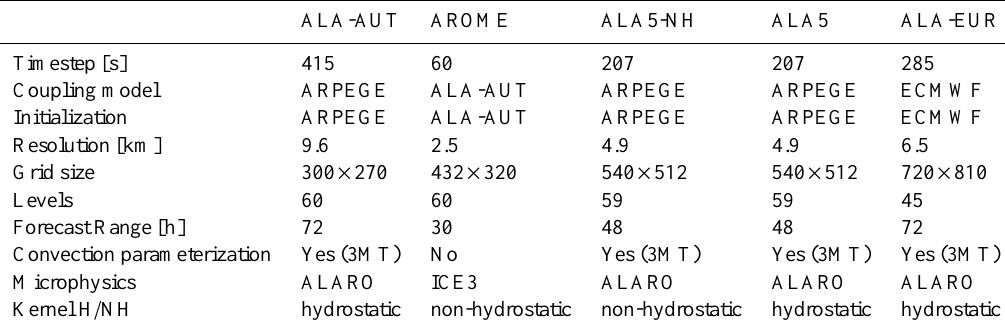
Table 1. Main characteristics of the di ff erent limited area models used at